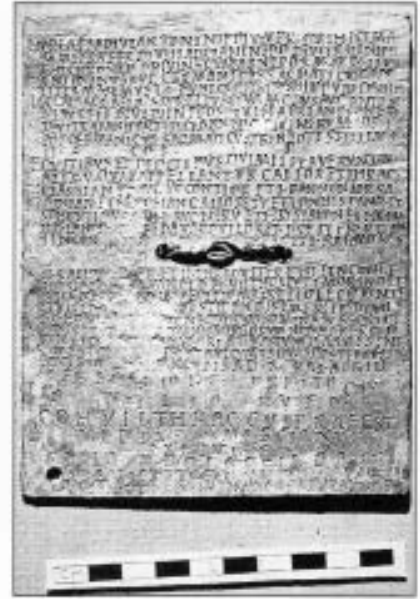
Figure 4 The outer text of a bronze mil­ itary diploma issued on 23 March AD 1 78, recording the grant by the emperors, Mar­ cus Aurelius and Commodus, of Roman citizenship to Thiodus, son of Rola, a Dacian serving in the seventh cohort of Thracians then stationed in Britain, The text (first published by Margaret Roxan as no. 184 in her third volume of Roman mil­ itary diplomas, 1 994, seen. 10 below) also contained new information on the history of Roman Britain as a whole, in particular concerning the governor at the time of the grant, Ulpius